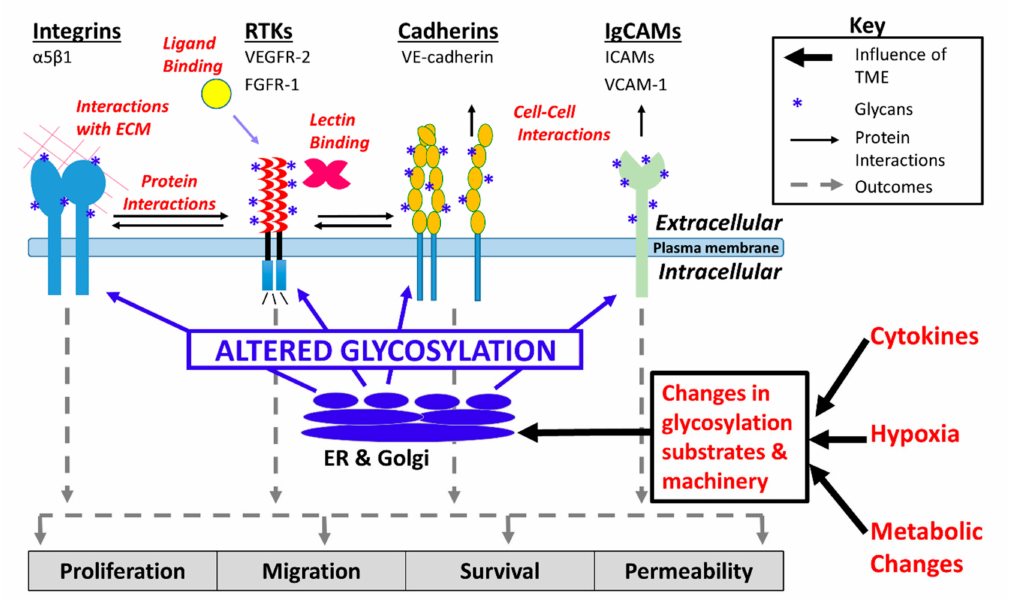
Figure 2. Tumor microenvironment-mediated changes in endothelial cell glycosylation. Endothelial glycoproteins are shown, including integrins, receptor tyrosine kinases (RTKs), VE-cadherin, and Ig-like cell adhesion molecules (IgCAMs). Glycans synthesized in the endoplasmic reticulum (ER) and Golgi have the potential to alter signaling and